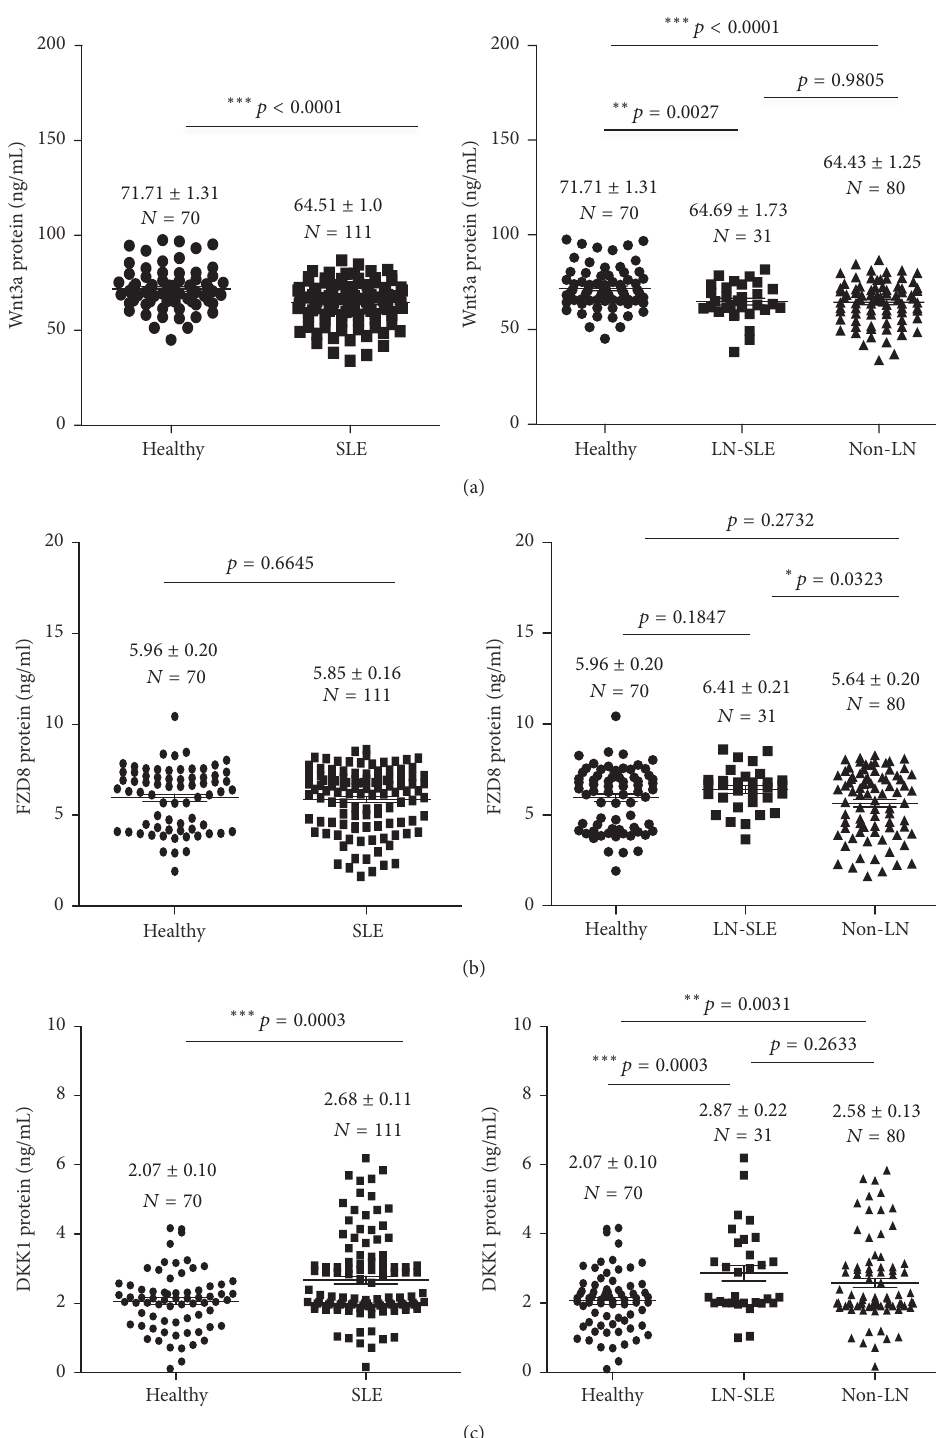
Figure 2: The concentrations of Wnt-3A, FZD-8, and DKK-1 proteins in urine of healthy individuals and SLE patients. (a) The concentration of urine Wnt-3A protein in healthy subjects and SLE patients. No statistical difference was determined between healthy individuals and SLE patients (left panel) and LN-SLE and non-LN-SLE patients as well (right panel). (b) The concentration of urine FZD-8 protein in healthy individuals and SLE patients. No statistical difference was determined between healthy individuals and SLE patients (left panel), but a moderately more abundant FZD-8 protein was found in the urine of LN-SLE patients compared with SLE patients without renal involvement (right panel, 𝑝 < 0.05 ). (c) The concentration of urine DKK-1 protein in healthy individuals and SLE patients. A statistical difference was found between healthy individuals and SLE patients (left panel, 𝑝 < 0.0001 ) but not between LN-SLE and non-LN-SLE patients (right panel, 𝑝 = 0.2633 ). Bars indicate the average levels of indicated proteins in each group. Compared with respective healthy and non-LN groups, ∗ 𝑝 < 0.05 , ∗∗ 𝑝 < 0.01 ∗∗∗ 𝑝 < 0.001 . Data presents as the mean ± SD in each